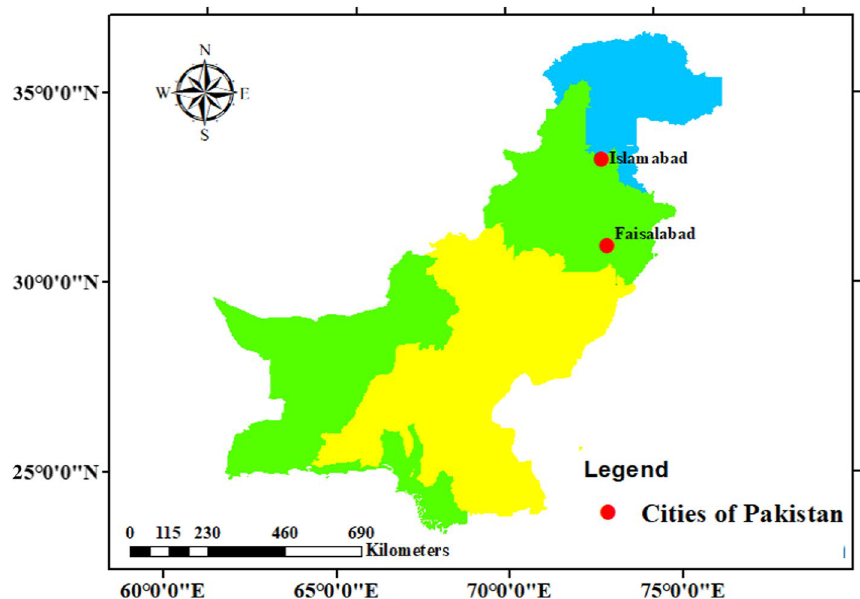
Fig. 1 Location map of the study